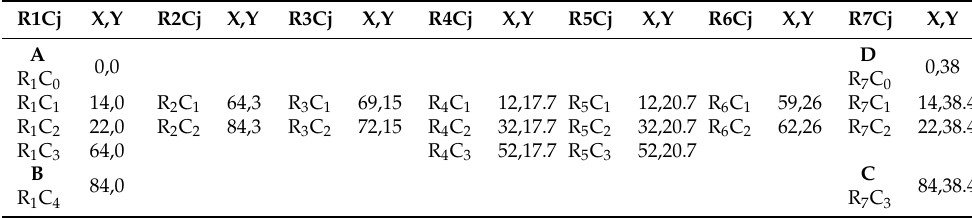
Table 7. The coordinates on the vertexes of edges in the layout